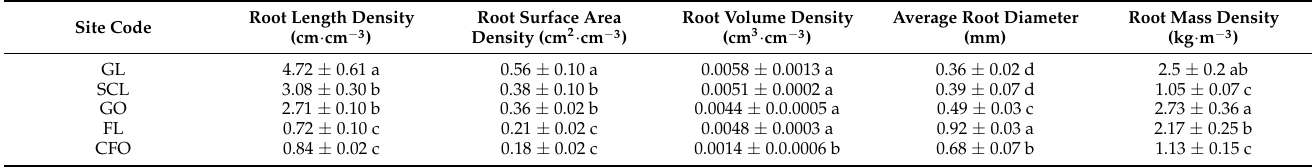
Table 1. Total root characteristics in different land use types.